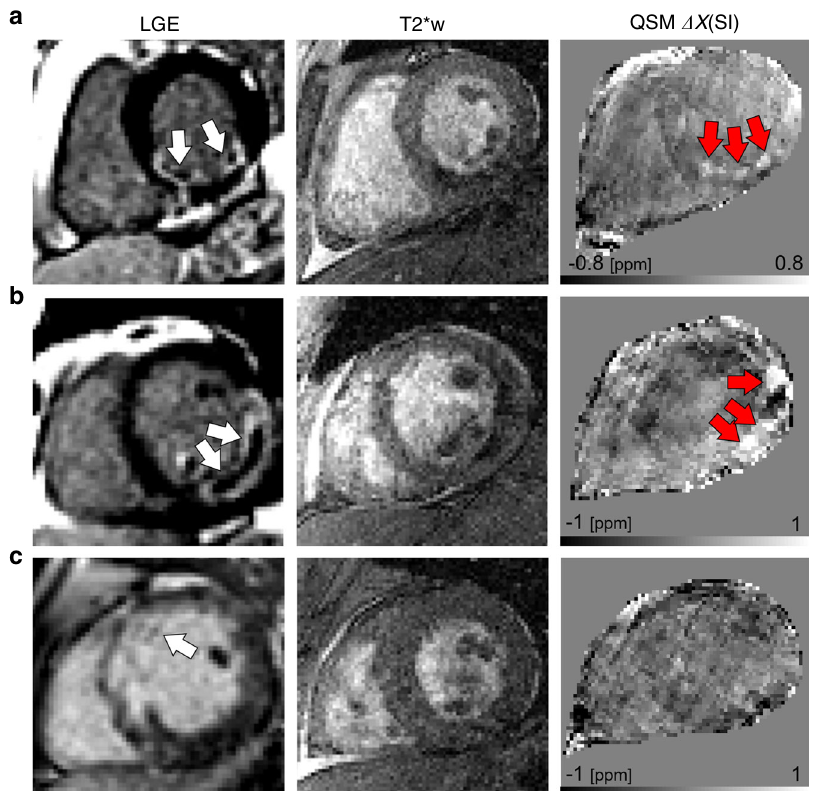
Fig. 6 Imaging of ST-elevation myocardial infarction patients after reperfusion therapy. a Patient had a nontransmural infarction with microvascular obstruction (LGE, white arrows), hemorrhage, and elevated magnetic susceptibility (QSM, red arrows). b Patient had substantial transmural infarction with microvascular obstruction, and signi fi cant hemorrhage and increases in magnetic susceptibility. c Patient shows a nontransmural infarction, minimal microvascular obstruction, and no substantial increase in magnetic susceptibility in the infarct region. All patients were reported to have TIMI grade 3 fl ow (no fl ow defects) following reperfusion and were imaged within 48 h after reperfusion therapy. T2*w images are at echo time (TE) 10